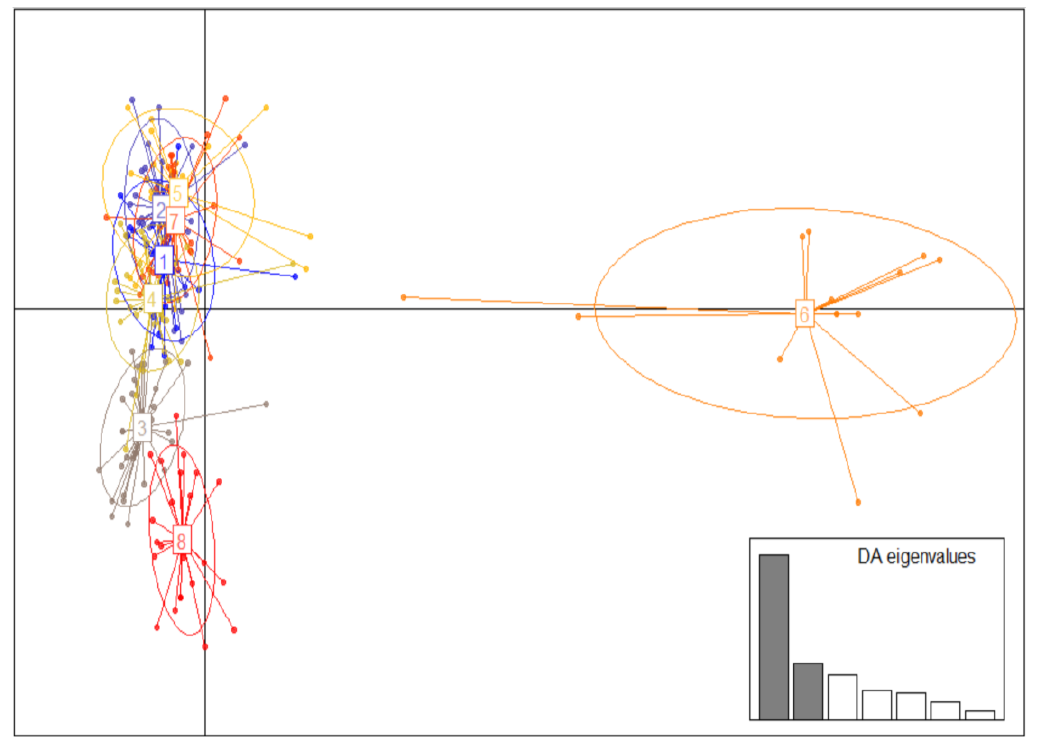
Figure 3. Gene clusters found with the DAPC analysis showing some structure in the captive population of scarlet macaws of Xcaret.